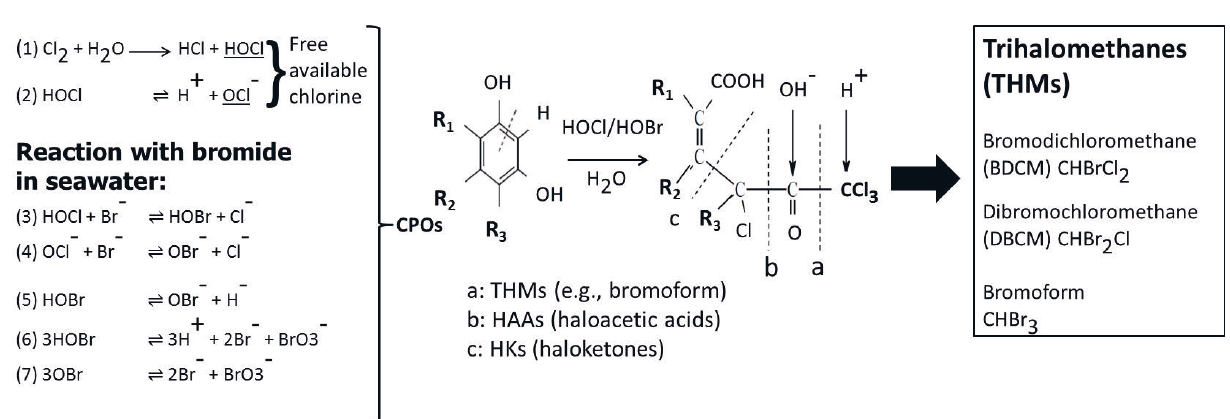
Figure 1. Outline of the chlorine and bromide pathway modified from [12], with